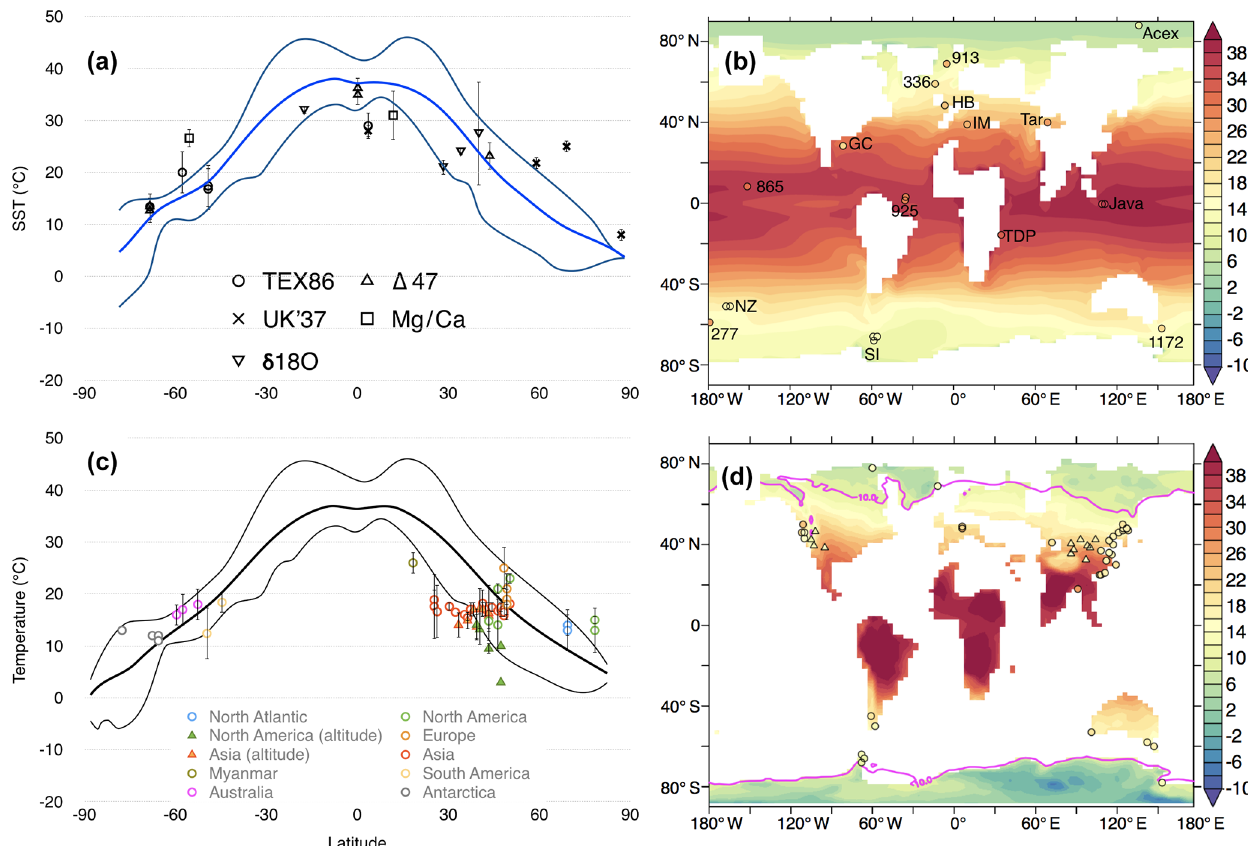
Figure 3. Late–middle Eocene global model–data comparison for (a, b) SST and (c, d) MAT. In (a) and (c) , thick line represents the mean temperature from EOC4X, thin lines the min and max latitudinal temperatures from EOC4X. For (d) terrestrial proxies, high altitude locations ( > 1000m) are represented by triangles, the others by circles, and the thick pink line represents the 10 ◦ C isotherm.